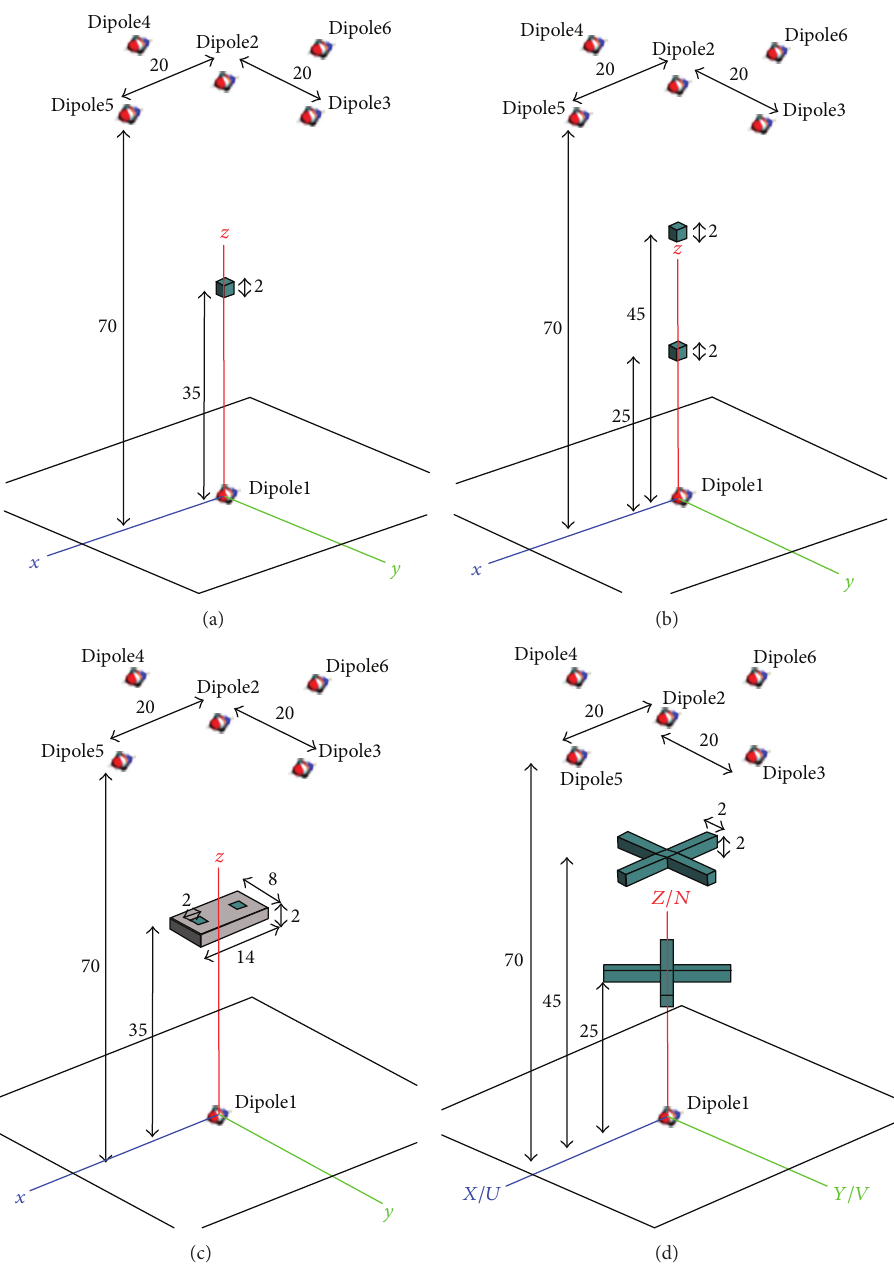
= 0.5 S/m. Imaging is performed for (a) a single b = 32 and 𝜎 = 1 S/m along the 𝑧 -axis, (c) two objects with 𝑟 o = 32 and 𝜎 = 1 S/m, and (d) 𝑟 m